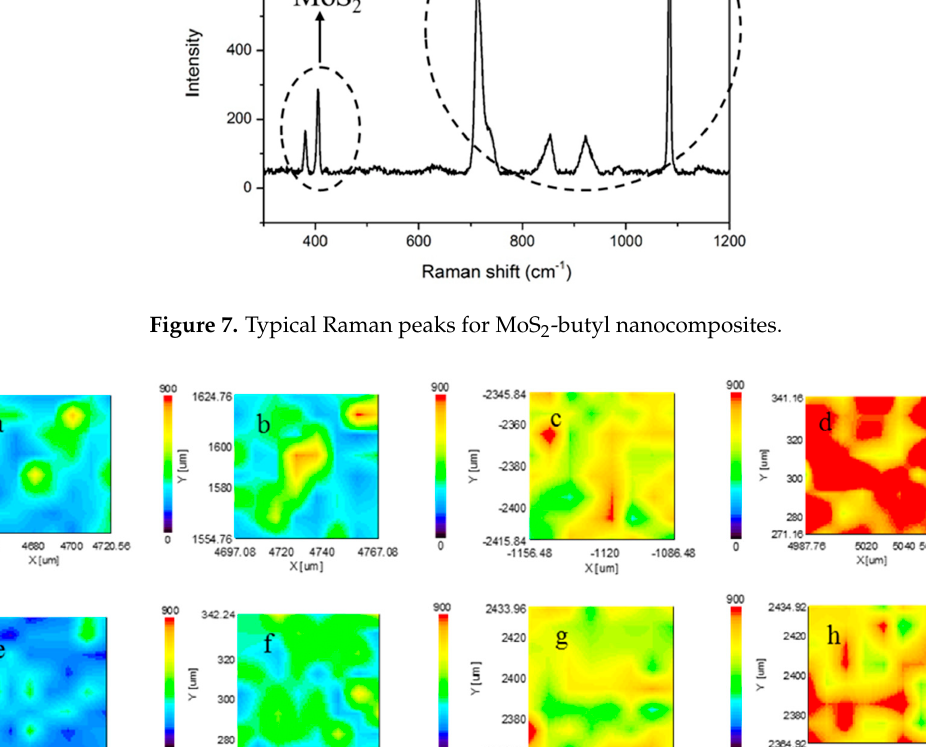
Figure 8. Raman mapping images for MoS 2 -butyl rubber with different concentrations of MoS 2 with